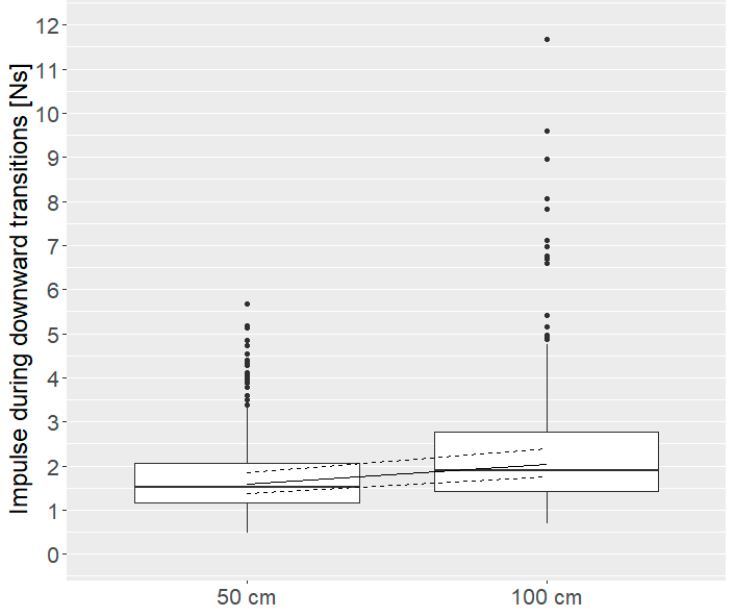
Figure 4. Impulse during downward landing (Ns) for 50 cm and 100 cm distance (distance: p = 0.001). Boxes show medians, lower and upper interquartile range. Whiskers indicate 1.5 times the interquartile range. In addition, model estimates with estimated means (solid line) and 95 % confidence intervals (dashed lines) are shown.